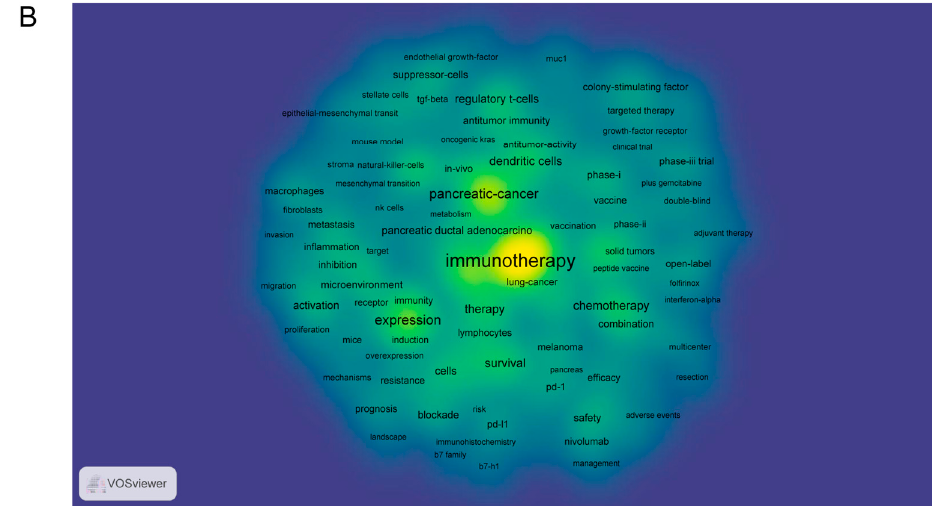
Figure 9. ( A ) Top 20 keywords with the strong citation bursts on immunotherapy for pancreatic cancer ( B ) density map of keywords generated by the VOS viewer.